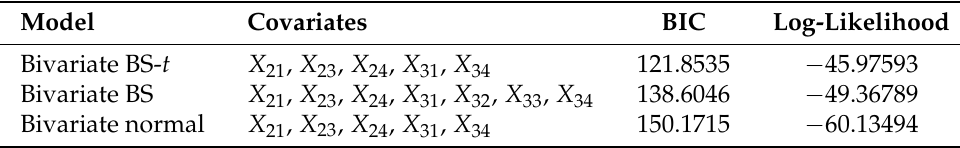
Table 6. BIC and log-likelihood values with Chilean PM data for the indicated model.